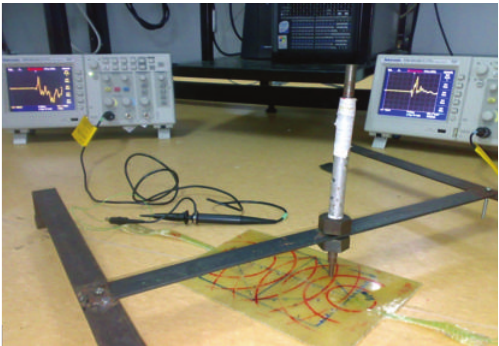
Figure 10: Experimental setup on the composite plate with two sensors.